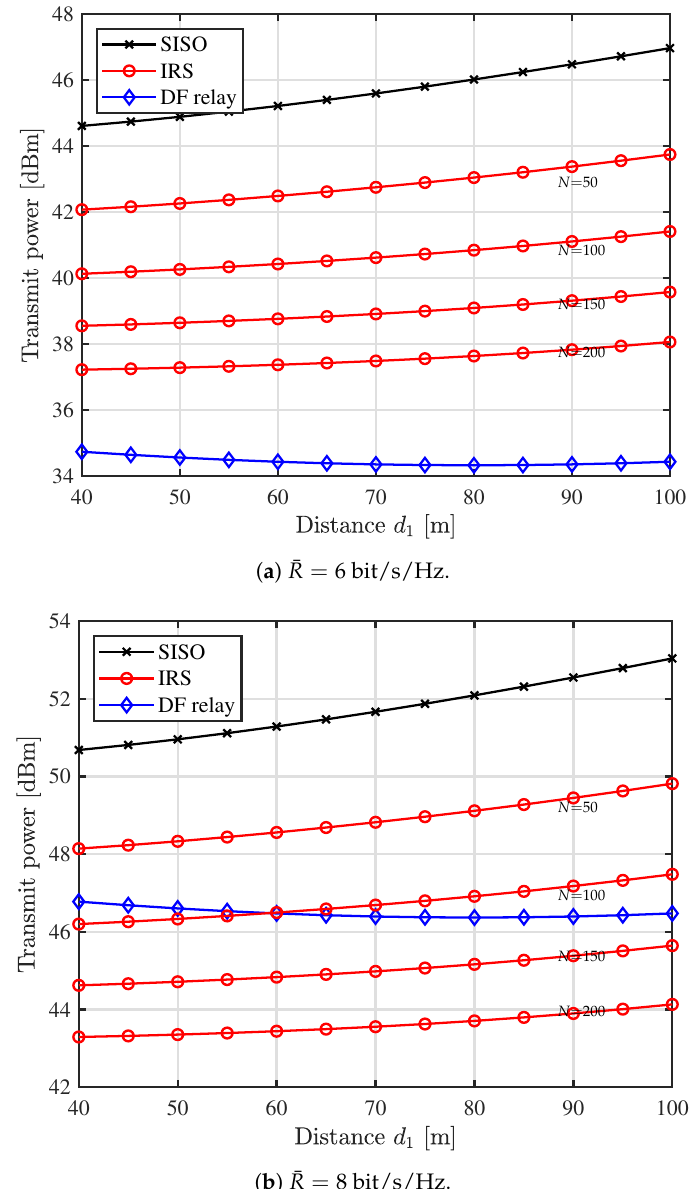
Figure 8. The transmit power based on varying distance d 1 with the number of users K = 100. Additionally, in Figure 9, we analyze the energy-efficiency of the three scenarios for perfect CSI with respect to the achievable rate as discussed in Section 3. Here, ν = 0.5, P s = P d = P r = 100 mW, and P e = 5 mW [15], d 1 = 100 m. We apply the optimal element number for IRS as derived in Equation (21) in order to find the maximum energy-efficiency. It can be seen from the figure that, although the peak energy-efficiency obtained for the DF relay case was higher than the scenario with IRS, the IRS-aided network maintained significant energy-efficiency levels throughout the entire range of the rate. Accordingly, it can be concluded that the IRS-aided communication showed better energy-efficiency compared with the other two scenarios for higher QoS